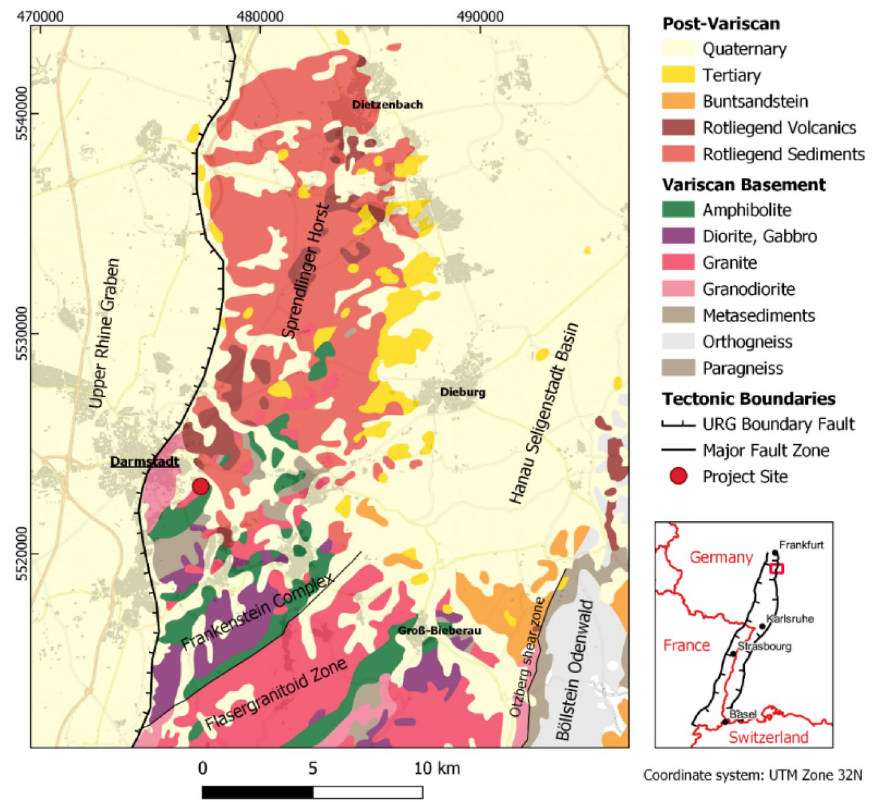
Fig. 2 Geologic overview of the Sprendlinger Horst and northern Odenwald (modified after GÜK300 Hessen, HLNUG